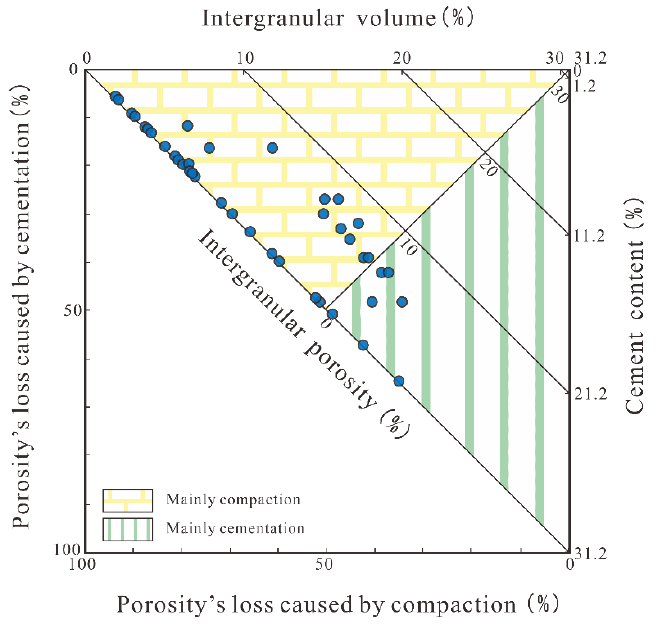
Figure 13. Influence of compaction and cementation on porosity evolution in the Niudong area, northern margin of Qaidam.